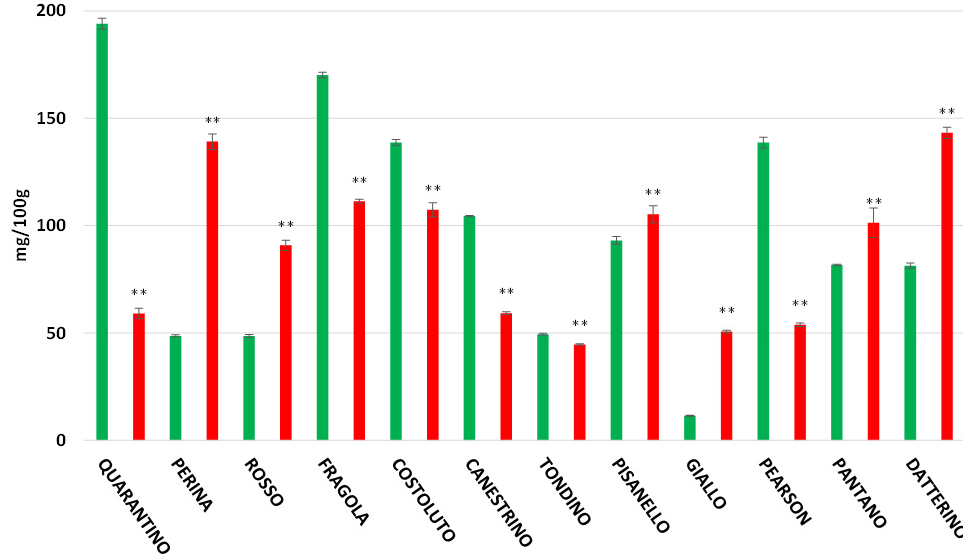
Figure 7. Total flavonoids content (expressed as mg/100 g of FW) in tomato peel of 9 Italian cultivars and three commercial cultivars. Controls (CTRL) in green and drought-stressed group (DS) in red. The bars indicate the standard deviation. A significantly difference is shown between CTRL and DS of each cultivar by ** for p ≤ 0.01.